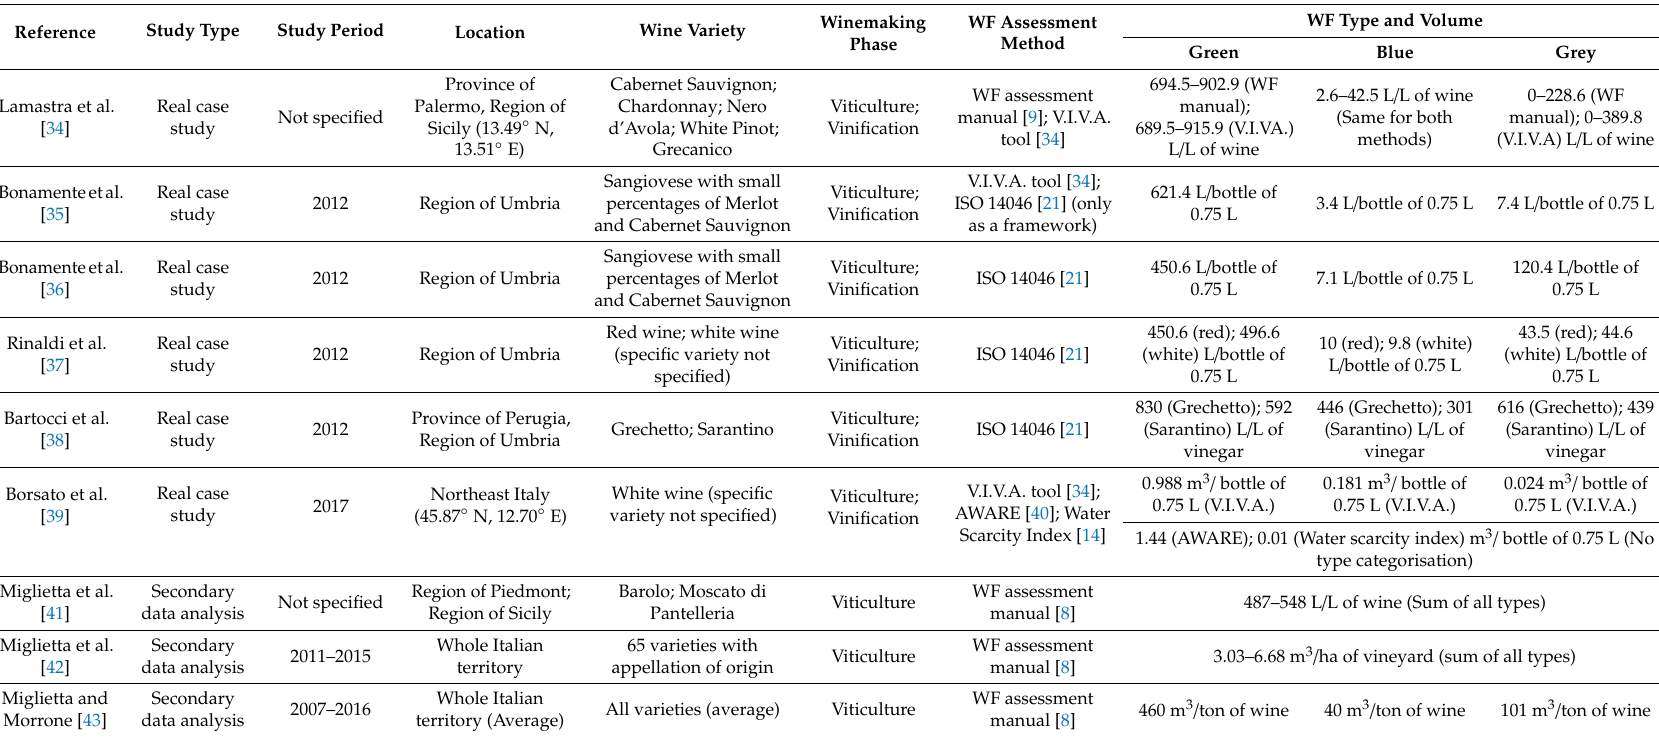
Table 1. Taxonomy of wine WF research in